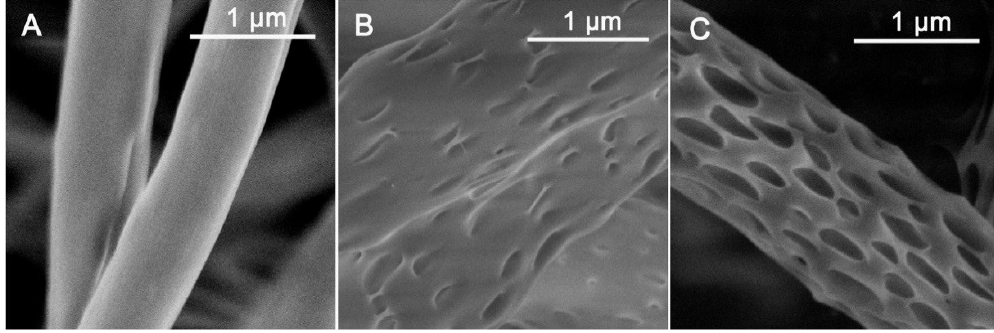
Figure 1. SEM of PDLLA fibers electrospun with different humidity at 25 °C. ( A ) 50%; ( B ) 65%; ( C ) 80%.